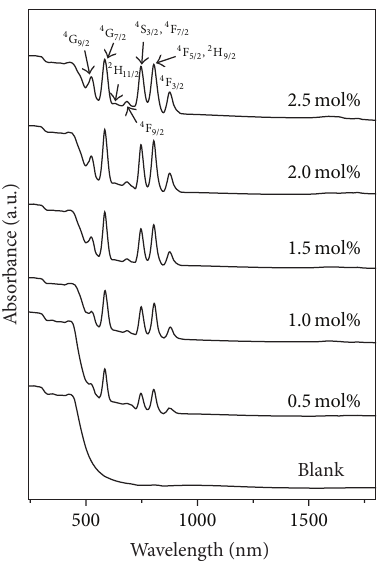
Figure 2: Ground state absorption spectra of Nd 3+ ions in Bi 2 O 3 – BaO–B 2 O 3 glasses at room